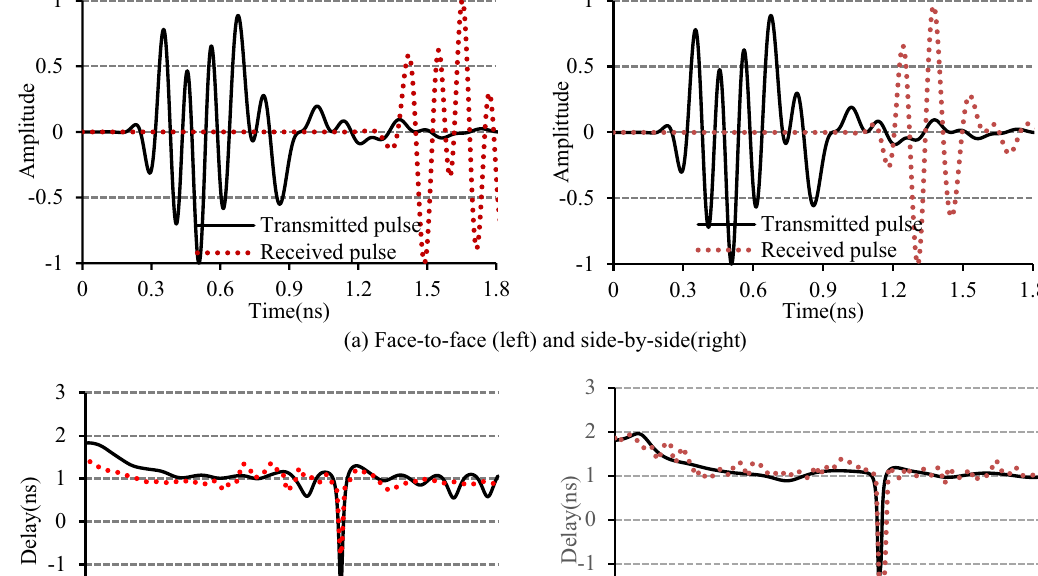
(c) Face-to-face (left) and side-by-side(right)